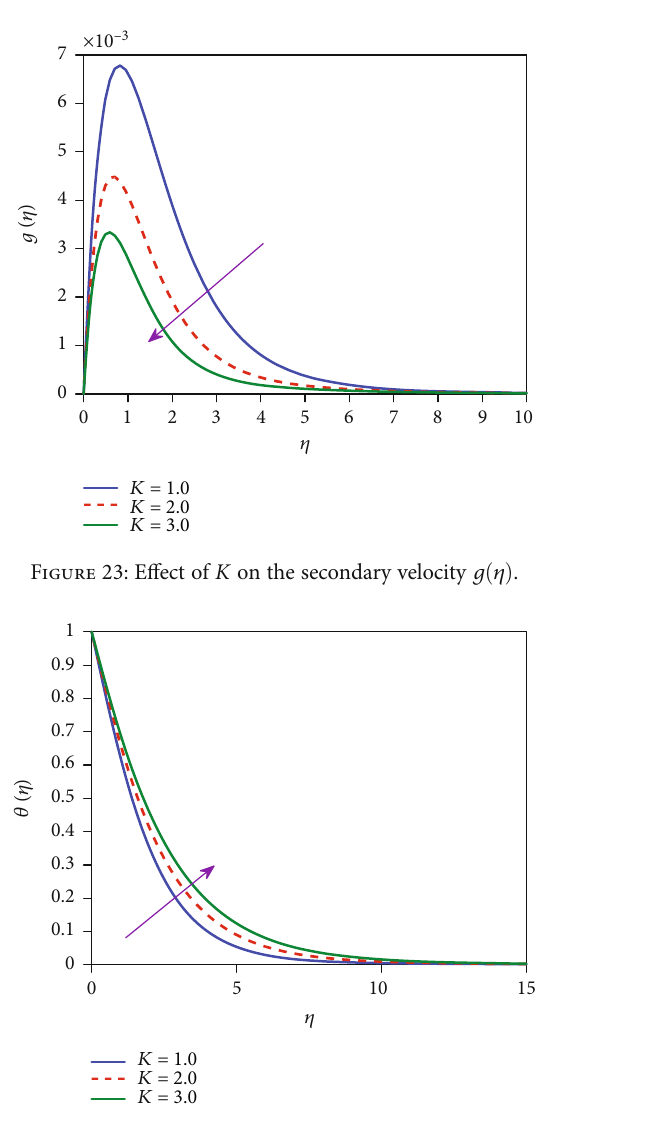
Figure 24: E ff ect of K on the temperature θ ð η Þ .